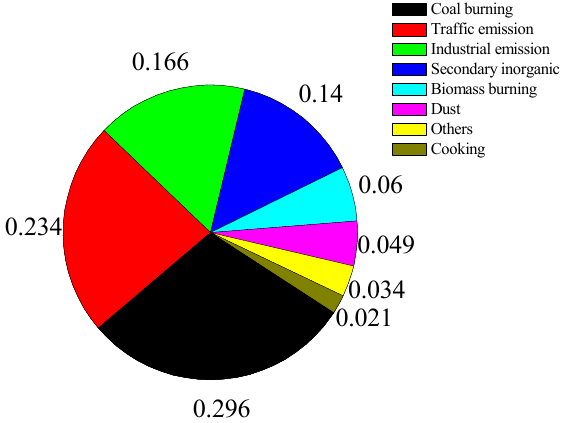
Figure 4. Number fractions for each group during sampling period. According to national ambient air quality standards (NAAQS) for particulate matter (PM) in 2012 (GB3095-2012), air quality is categorized on the basis of PM 2.5 values as follows: 0–35 µ g/m 3 , excellent; 35–75 µ g/m 3 , good; 75–115 µ g/m 3 , slight pollution; 115–150 µ g/m 3 , moderate pollution; and 150–250 µ g/m 3 , severe pollution. In our sample, the air quality was divided into four grades: excellent, good, slight pollution, and moderate pollution. Figure 5 presents the number fractions of the eight particle types under various pollution cases. As the average PM 2.5 mass concentration increased from 28 to 95 µ g/m 3 , the air quality changed from excellent to slight pollution, the number fraction of traffic emissions increased from 21.1% to 25.3%, and the number fraction of secondary inorganic sources increased from 12.2% to 16.3%. As the average PM 2.5 mass concentration increased from 95 to 125 µ g/m 3 , the air quality changed from slight pollution to moderate pollution, the number fraction of coal burning increased from 26.8% to 27.3%, and the number fraction of dust increased from 4.2% to 5.4%. These findings indicated that the increase in PM 2.5 during the sampling period was influenced mainly by the increase in coal burning, traffic emissions, secondary inorganic aerosols, and dust.